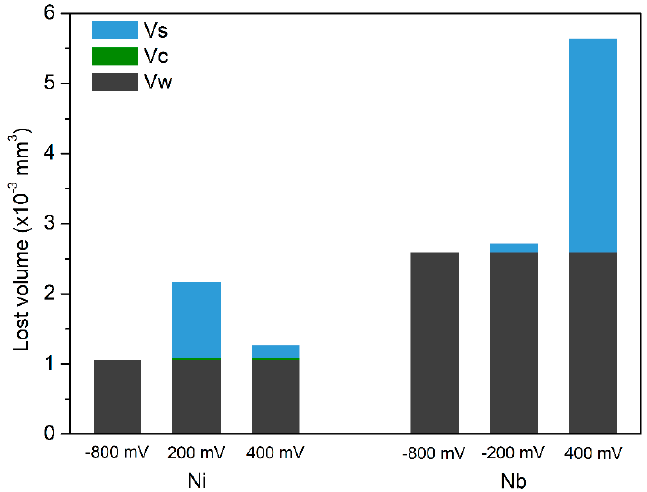
Figure 9. Contribution of corrosion, wear and their synergic interactions to the total material loss volume of Ni and Nb in potentiostatic tribocorrosion tests with different applied potentials.